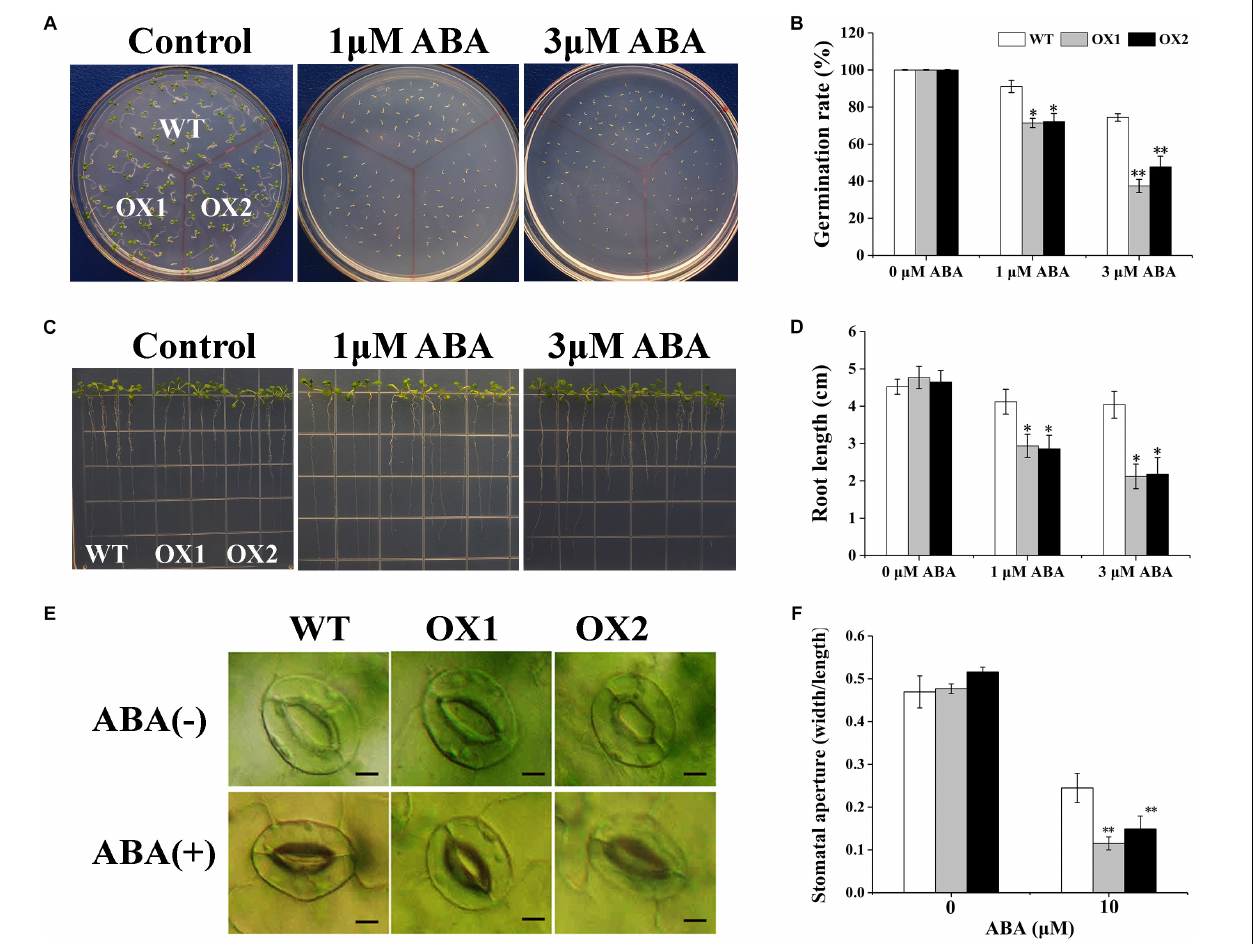
FIGURE 9 | Responses of OoNAC72 -OX plants to ABA. (A,B) Seed germination assay between OoNAC72 -OX and WT Arabidopsis plants. The surface-sterilized seeds were sowed on 1/2 MS solid medium supplemented with 1 and 3 µ M ABA incubated at 22 ◦ C. (C,D) Root length assay between OoNAC72-OX and WT Arabidopsis plants. Five-day-old seedlings were cultured vertically on 1/2 MS solid medium supplemented with 1 and 3 µ M ABA for 7 days. (E,F) Stomatal closure of WT and OoNAC72 -OX plants with 10 µ M of ABA. Values are means ± SD ( n = 50) in assays. Asterisks indicate statistically significant differences from WT. ∗ P < 0.05, ∗∗ P <